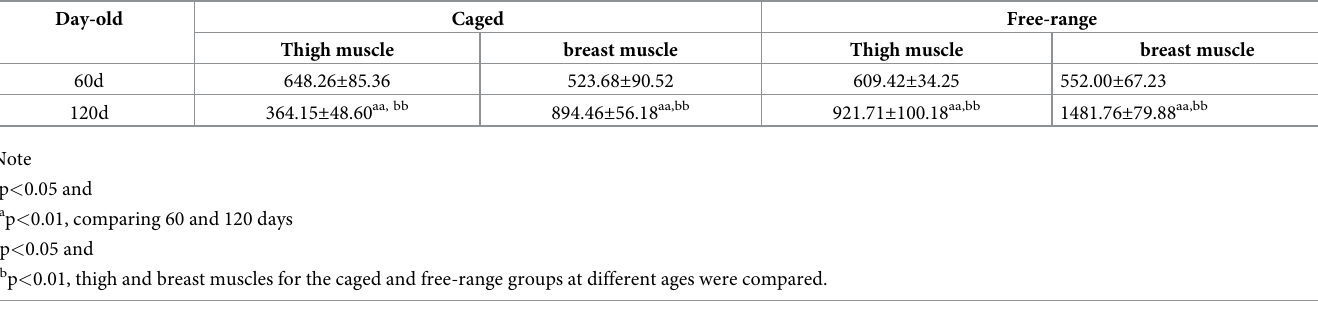
Table 2. Determination of IMP content in the muscle.